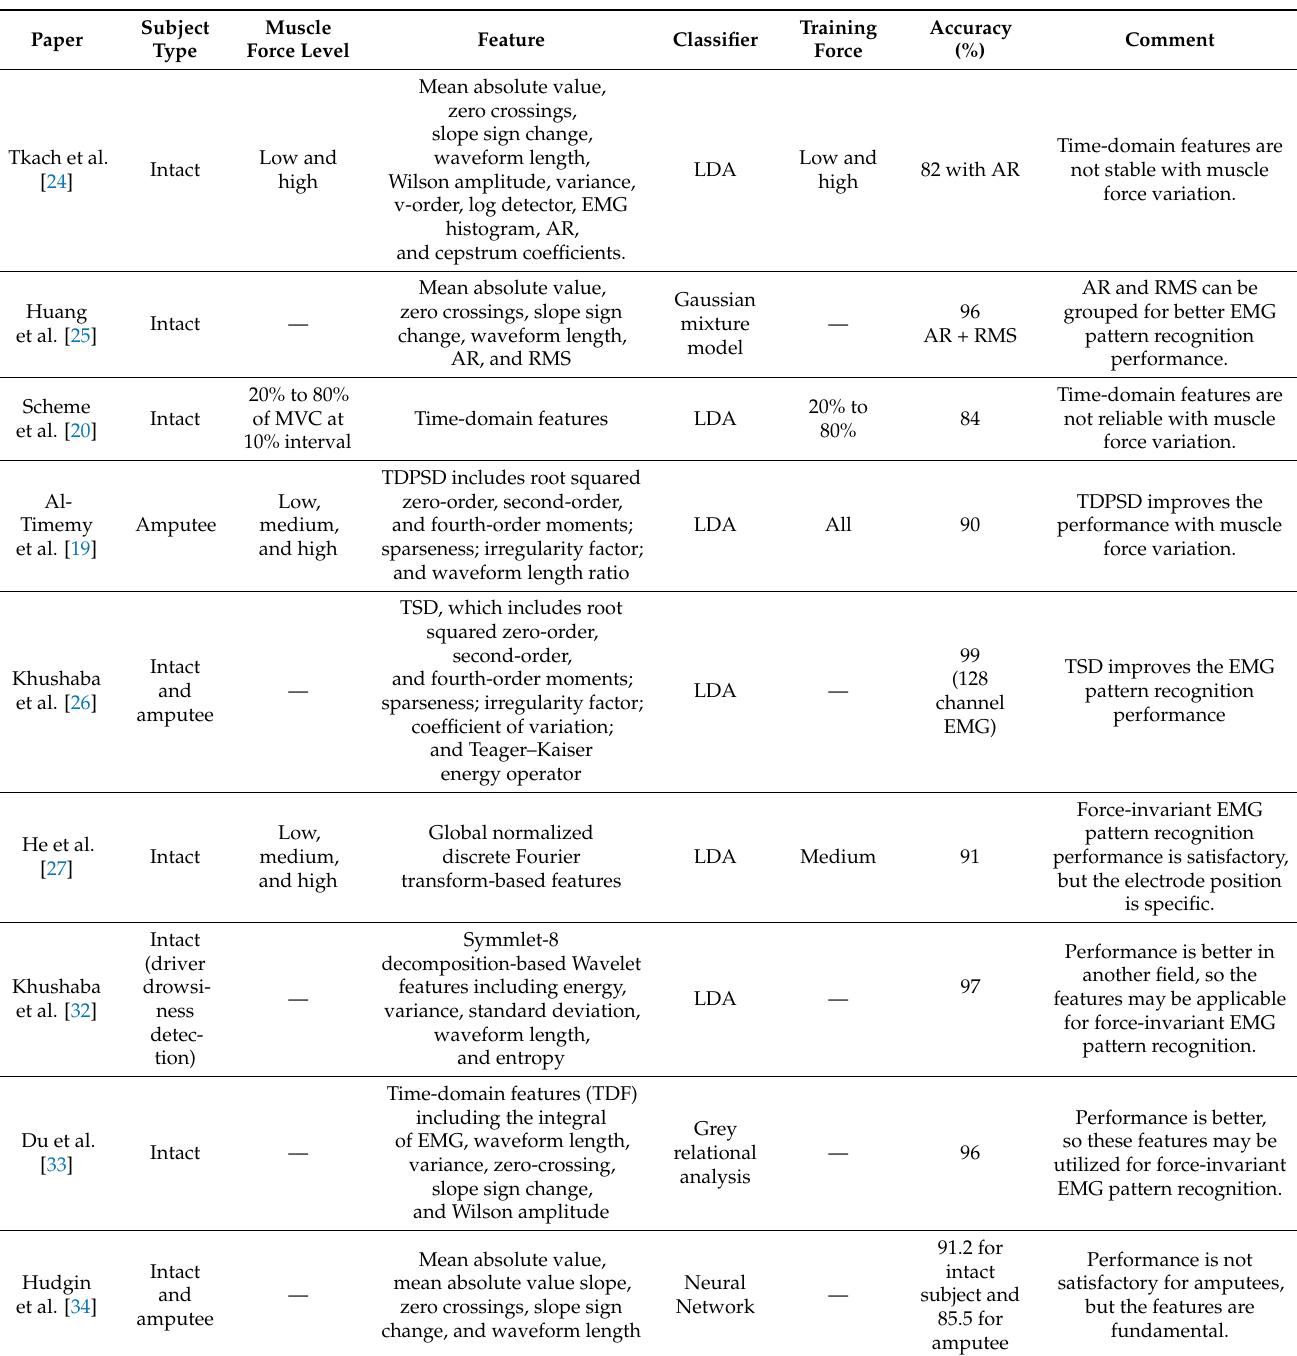
Table 1. Different feature extraction